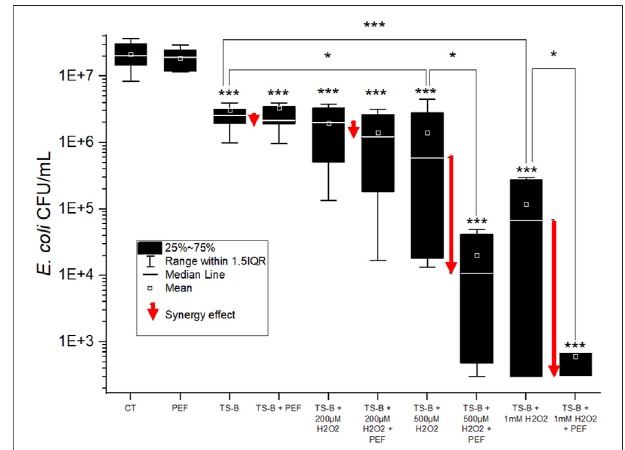
FIGURE 8 | E. coli population (CFU/ml) for the different treatments in PAW induced by the TS-B closed air reactor without and with adding different concentrations of H 2 O 2 and without and with PEF treatment. The white dot is the mean, black line in the gray scar is the median, square is the Q1 and Q3, and the whiskers are the extremes value of the experiment. One-way ANOVA test, (*) p -value < 0.05; (**) p -value < 0.01; (***) p -value < 0.001 with respect to control (CT), or other conditions as indicated by lines. Boxes and whiskers show the median, mean value, interquartile range (IQR), and error bars corresponding to 1.5IQR. Red arrows indicate the bacterial population reduction due to synergy of PEF and PAW.